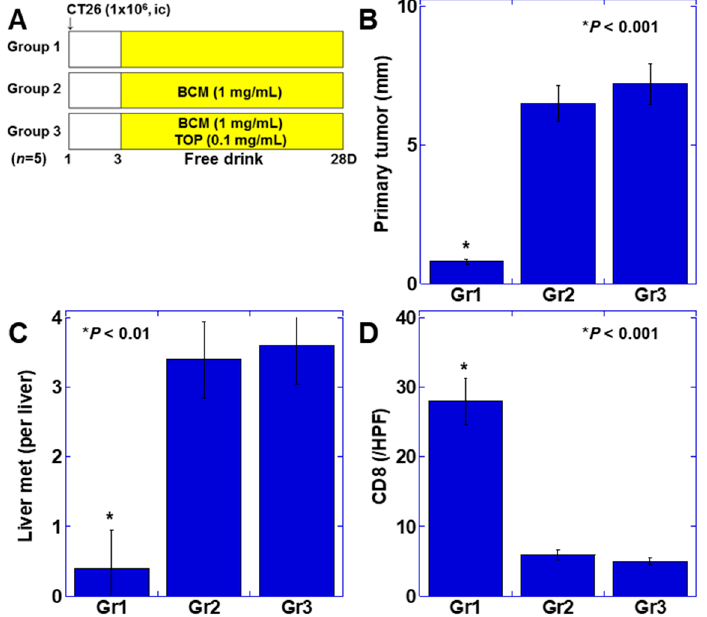
Figure 5. Effect of BCM on colon cancer metastasis in mice. ( A ) CT26 mouse colon cancer cells were inoculated in the cecum. The mice were treated with BCM+TOP mixed in drinking water. ( B ) Diameters of primary tumors in the cecum. ( C ) Number of liver metastasis. ( D ) CD8 + T cells in the primary tumors were examined by immunostaining. Error bar, standard deviation from three independent trials. BCM, β -casomorphin-7; TOP, thiorphan; Gr, group.